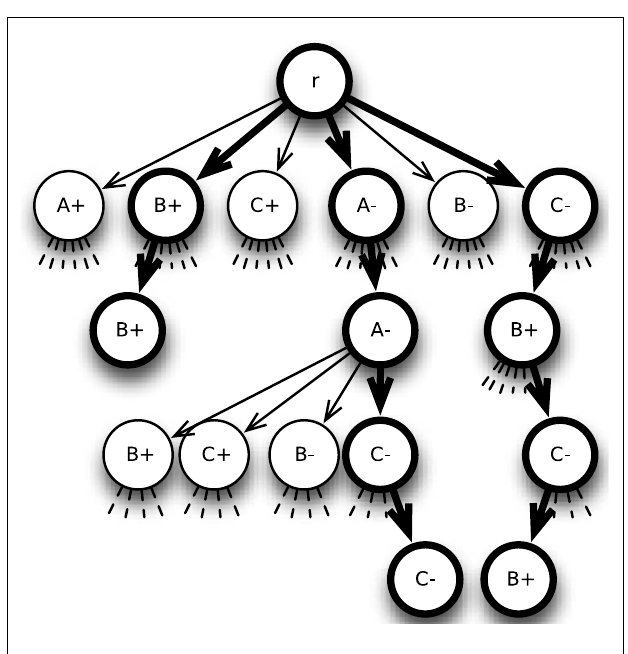
FIGURE 4 | 6-Ary tree for choice between three alternatives A , B , and C with decision thresholds θ + = 2 and θ − = 2 and three-different sample paths that lead to choice of alternative B